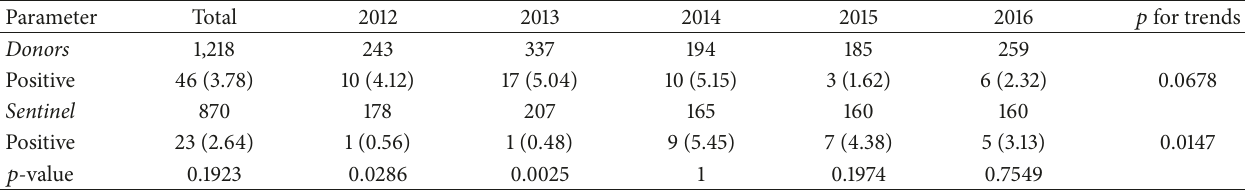
Table 3: Year-on-year prevalence of new HIV infection (15–24 years) among blood donors and pregnant women in the Ho municipality. Parameter Total